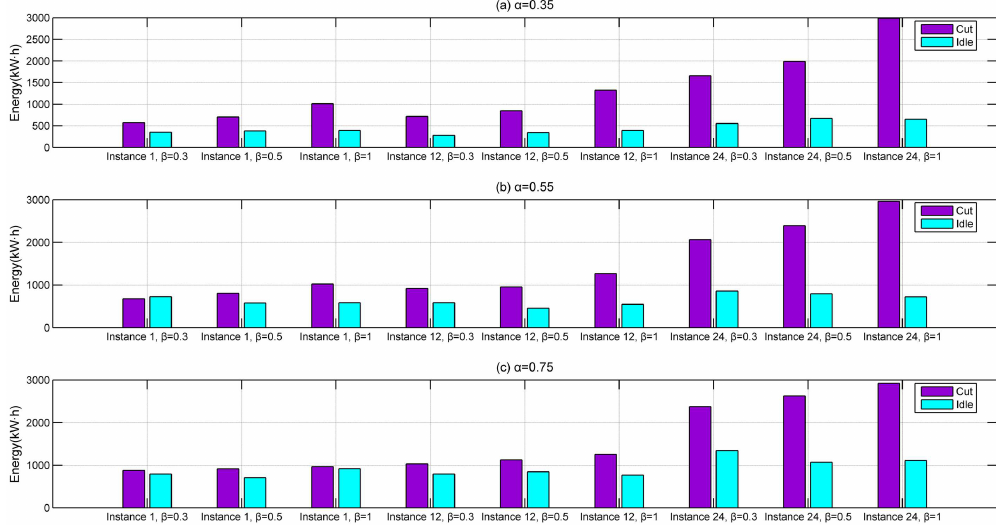
Figure 10. The energy consumption of three